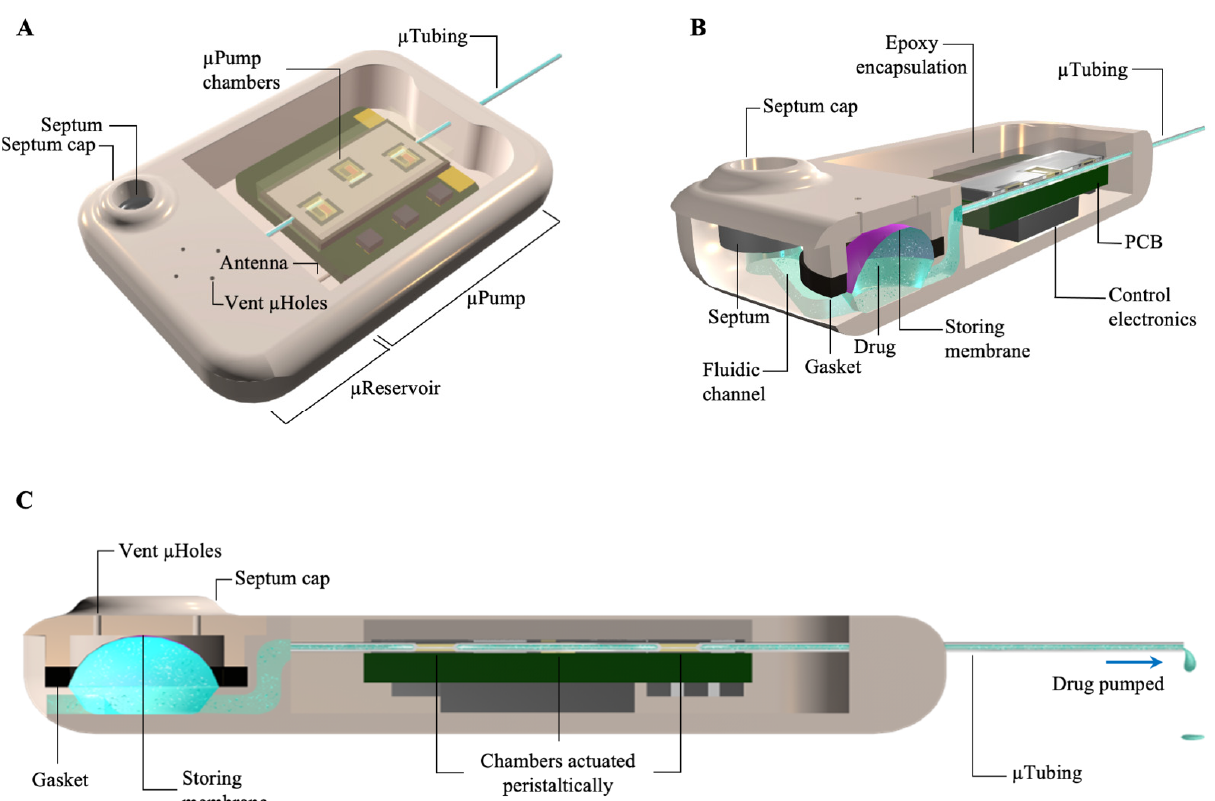
Figure 1. A schematic view of the pump microsystem. ( A ) An isometric view of the device showing the overall structure. ( B ) A cutaway view of the device showing the fluidic path from the refill port to the storing area and the micropump. ( C ) A side cutaway view of the device showing the fluidic path in the microcatheter from the reservoir, through the pumping chambers, and out to delivery.